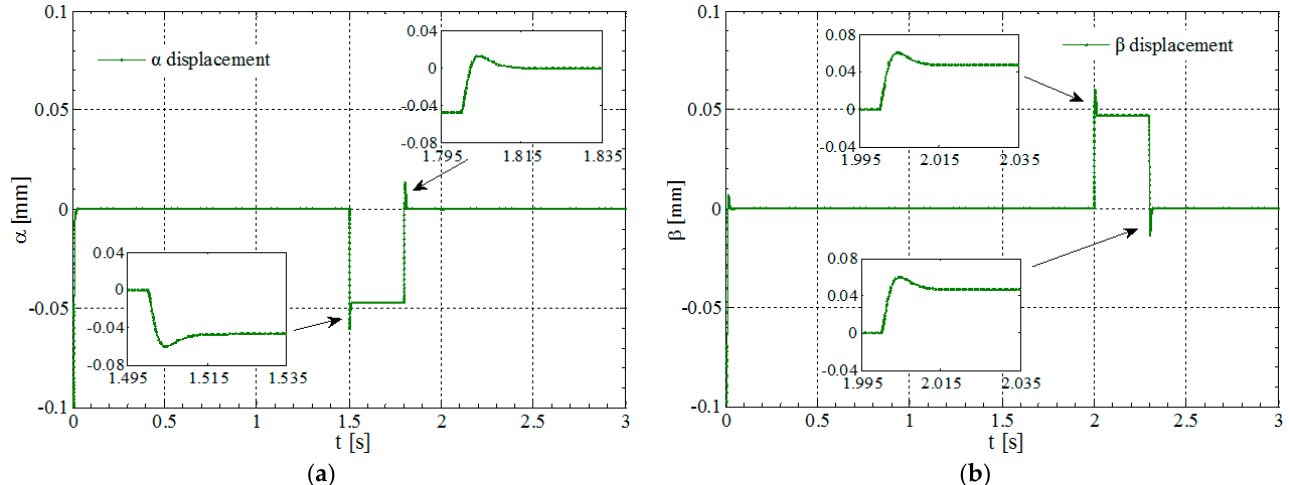
Figure 10. Displacement response waveforms: ( a ) α displacement component; ( b ) β displacement component.